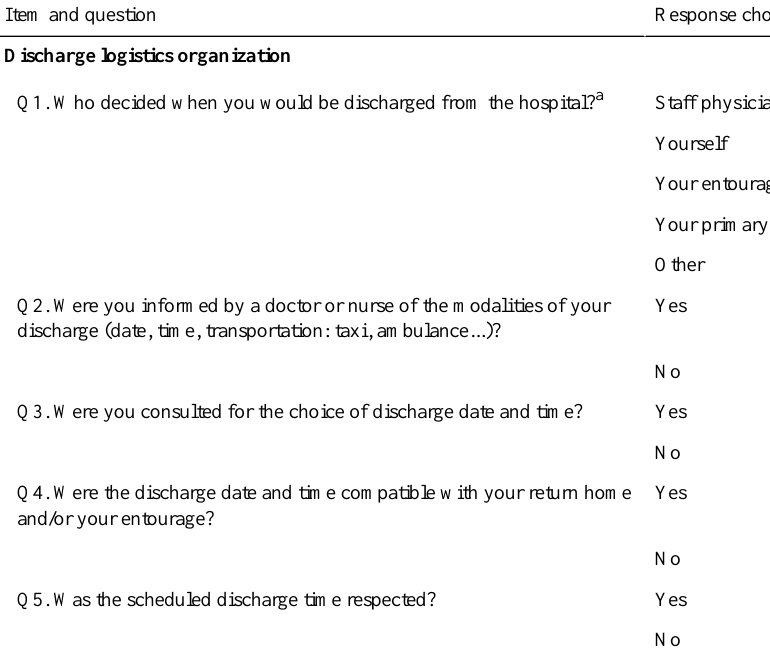
Table 1. Discharge questionnaire and satisfaction scoring. Discharge logistics